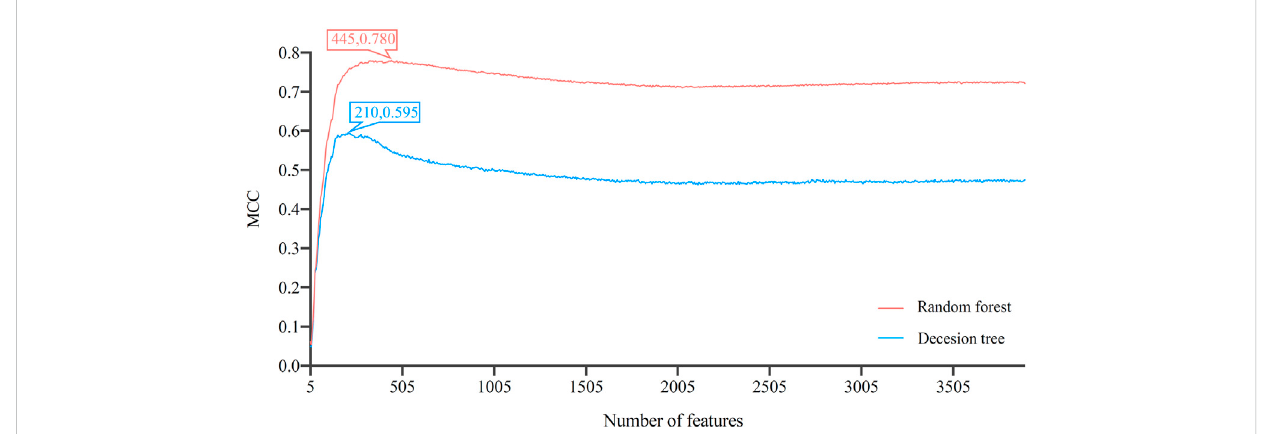
FIGURE 2 Incremental feature selection(IFS) curves ofdecision treeand randomforest. Theoptimalclassi fi cationperformancealone withtheoptimalfeature number for each algorithm has been labeled on the curve. Random forest has better classi fi cation results than decision tree.